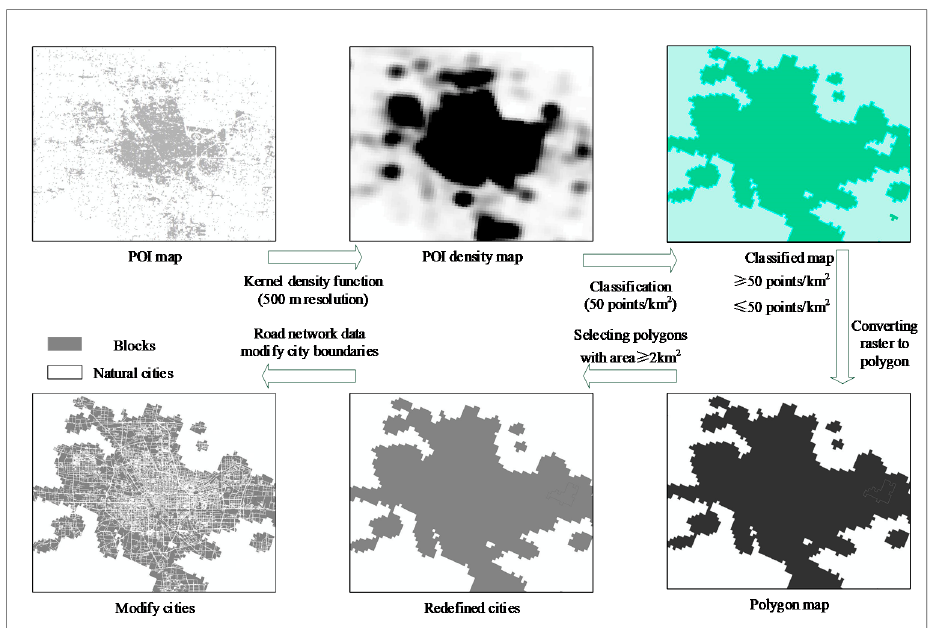
Figure 3. A diagram of POI-based method to redefine cities: an example of a natural city of Zhengzhou, a prefectural level city in Henan province, China.